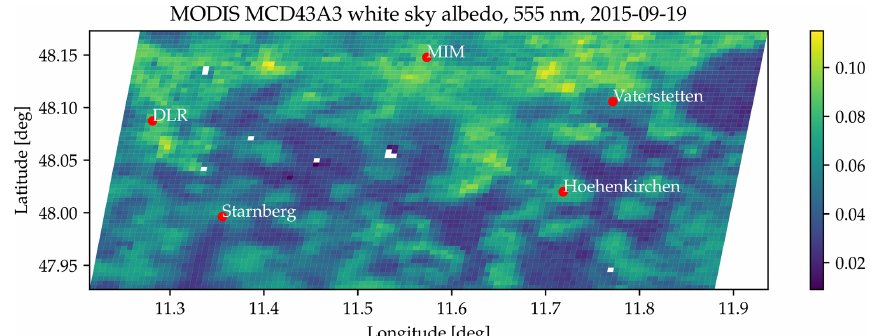
Figure B5. MODIS MCD43A3 white-sky albedo from 19 September 2015 at a wavelength of 555nm displayed for the geographic region which is covered by the projected 22 ◦ halo between sunrise and sunset throughout the year. The Meteorological Institute of LMU in Munich is marked by a red dot and labeled with “MIM”. Some more locations, e.g., the DLR in Oberpfaffenhofen, are marked for orientation.